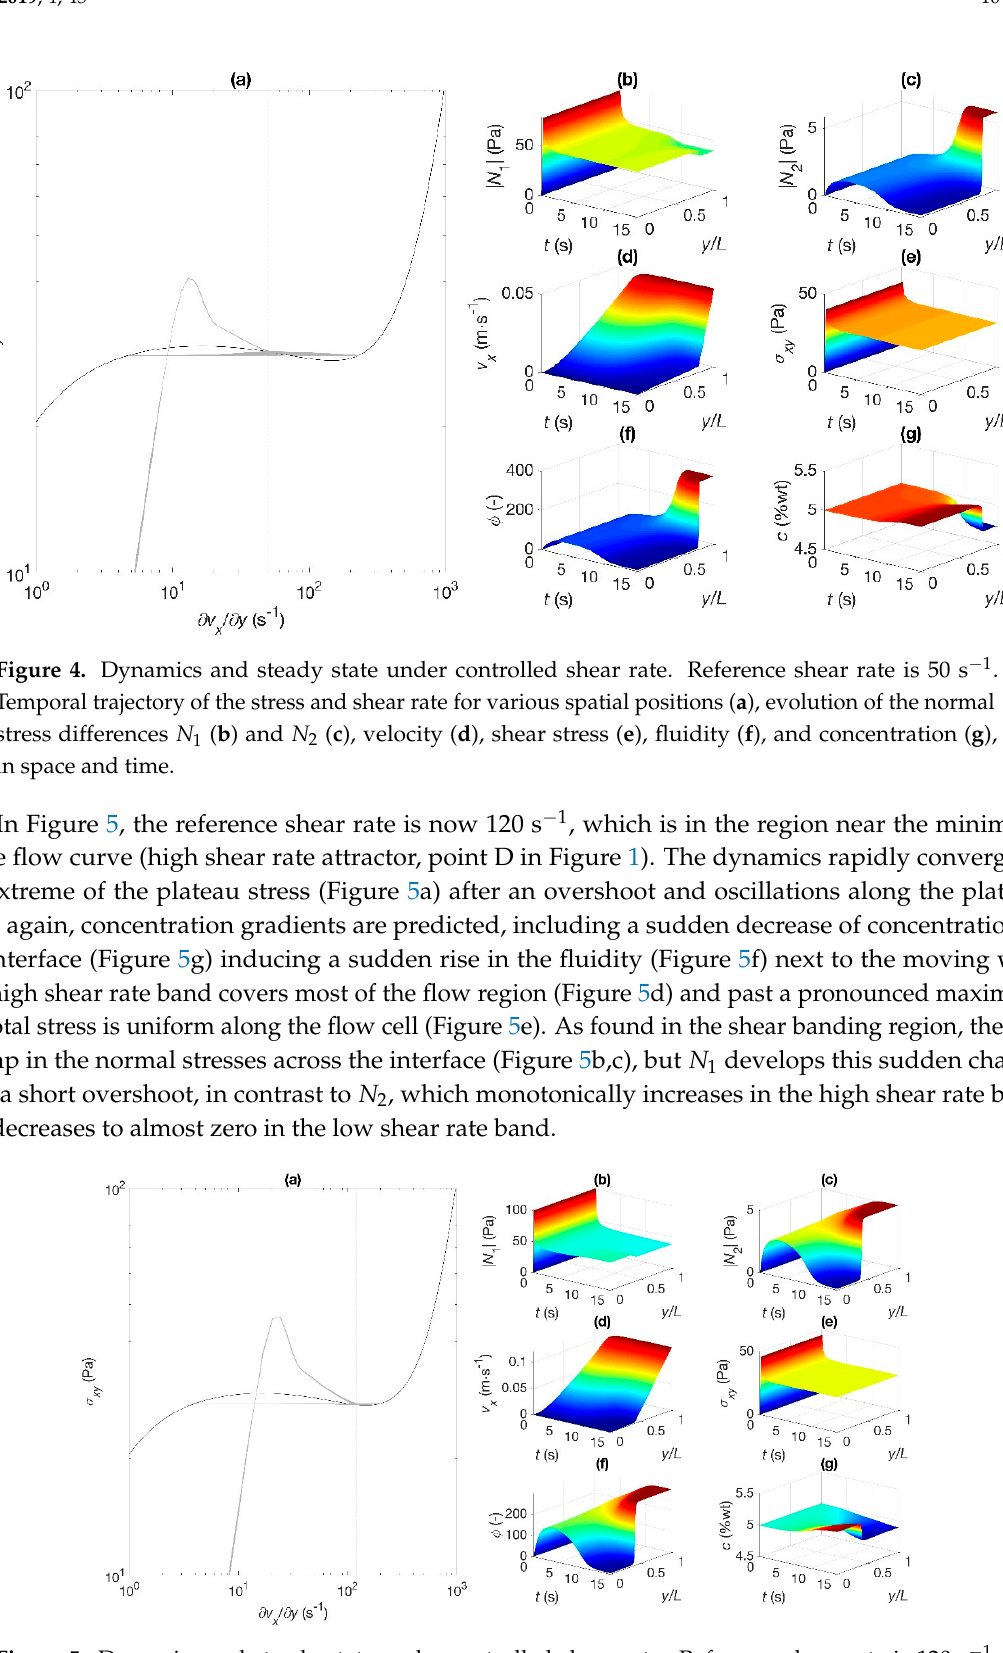
Figure 3. Dynamics and steady state under controlled shear rate. Reference shear rate is 10 s − 1 . Temporal trajectory of the stress and shear rate for various spatial positions ( a ), evolution of the normal stress differences 𝑁 (cid:2869) ( b ) and 𝑁 (cid:2870) ( c ), velocity ( d ), shear stress ( e ), fluidity ( f ), and concentration ( g ), in space and time.